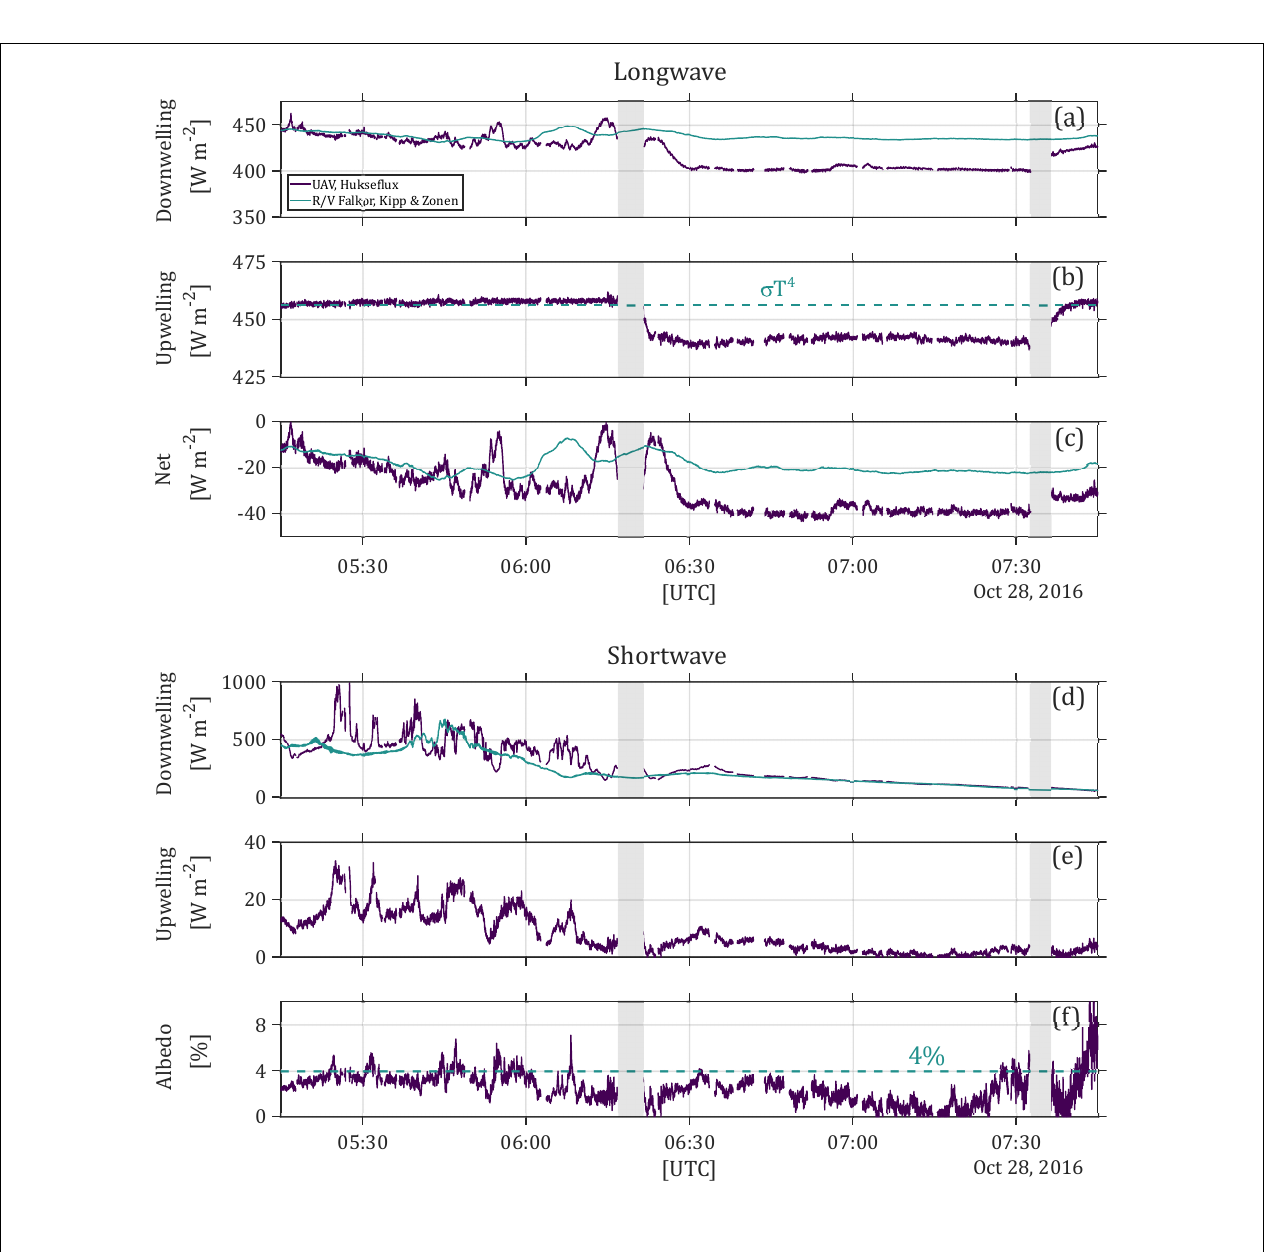
FIGURE 10 | Radiant flux sensed via the pyrgeometers (longwave, a–c ) and pyranometers (shortwave, d–f ) from UAV Flight 001. The pyrgeometers are sensitive to electromagnetic radiation in the wavelength range of 4.5–40 µ m, while the pyranometers are sensitive to electromagnetic radiation in the wavelength range of 285–3000 nm. The violet and teal traces always represent measurements made via UAV and ship, respectively. The gray shaded regions indicate the times of ascent and descent of the UAV. The dashed line in (b) represents theoretical radiation computed using the sea surface temperature and an assumed emissivity of 0.96. The dashed line at 4% in (f) represents the classical value of Payne (1972) which is typical for clear skies and high solar angle.